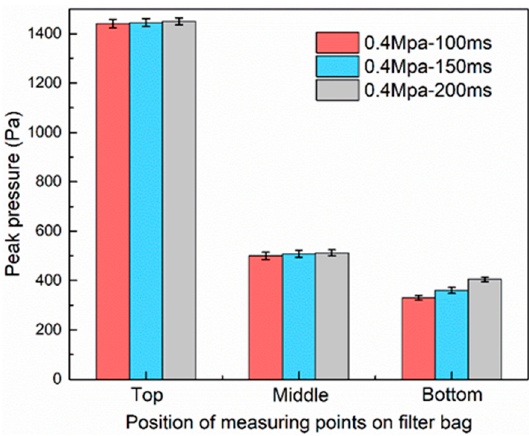
Figure 7. Effect of the pulsing air injection time on peak pressure of filter bag. Figure 7. E ff ect of the pulsing air injection time on peak pressure of filter